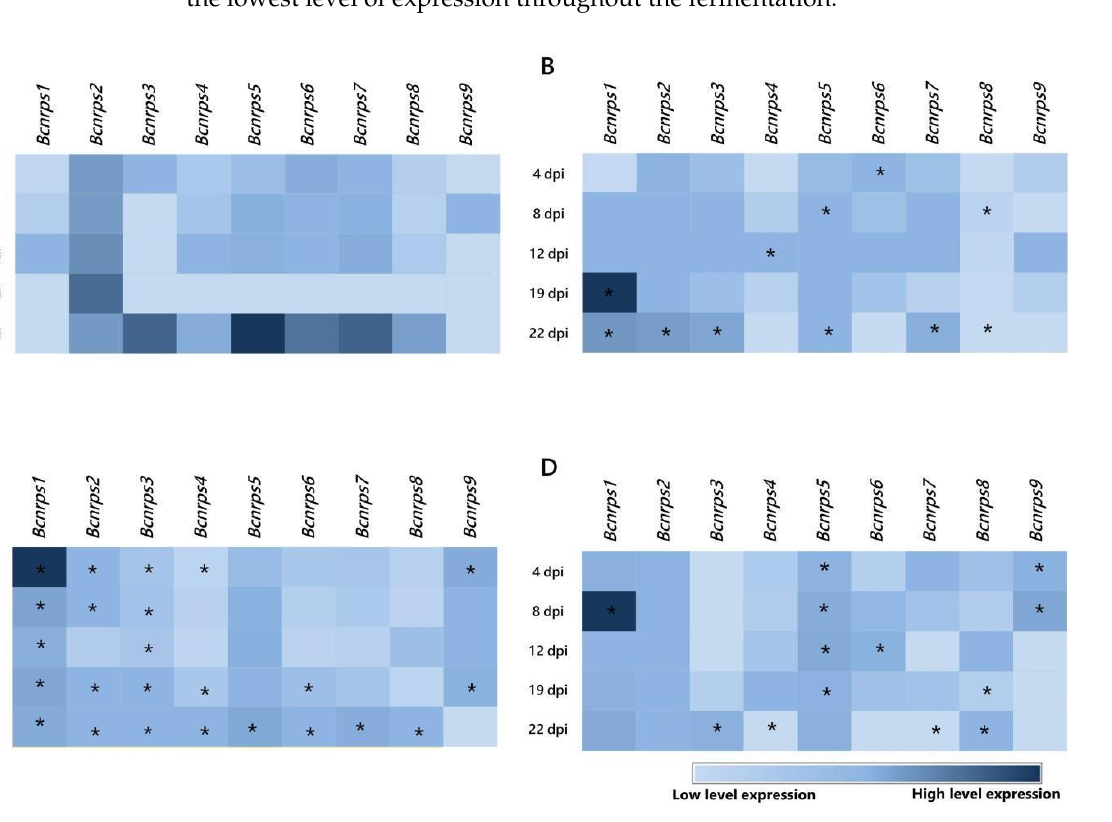
Figure 2. Heatmap of the expression profiles of the 9 Bcnrps genes during fermentation of B. cinerea B05.10 strain in the absence and presence of polyamines. The mean normalized expression (MNE) shown here is an average of the two MNE estimated using actin and β -tubulin as reference genes. ( A ) Malt extract medium (control), ( B ) malt extract supplemented with 10 µM SPM, ( C ) malt extract supplemented with 350 µM SPD, and ( D ) malt extract supplemented with 1.5 mM 1,3-DAP. Asterisks indicate significant differences of the 9 genes expressions between each supplemented medium and ME medium without PAs on different days of the study, according to two-way ANOVA, post hoc Tukey ′ s test for the factors media type and dpi (* p -value < 0.05).